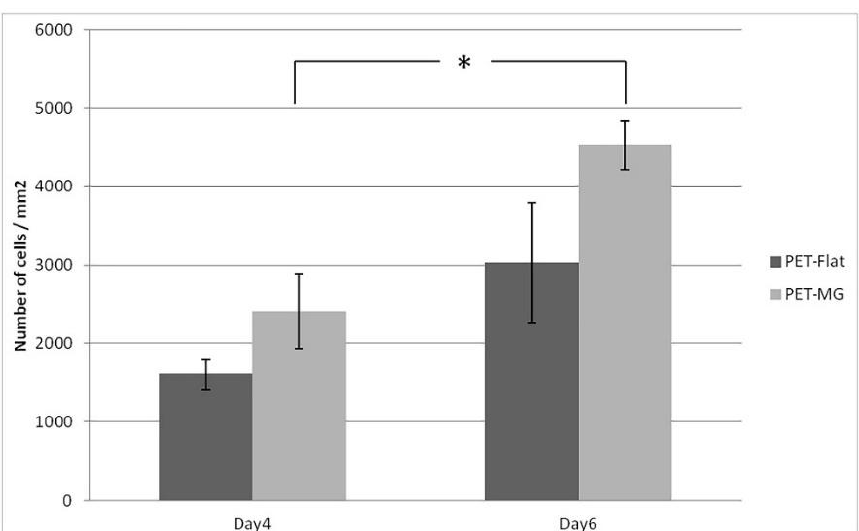
Figure 9. Proliferation of Schwann cells (number of cells/mm 2 ) cultured on the PET substrates (PET-MG and PET-Flat) (via DAPI) for 4 and 6 days. The data were subjected to ANOVA with post hoc Tukey HSD test. A significant difference (* p < 0.0.5) was observed between 4 days and 6 days for the PET-MG substrate.